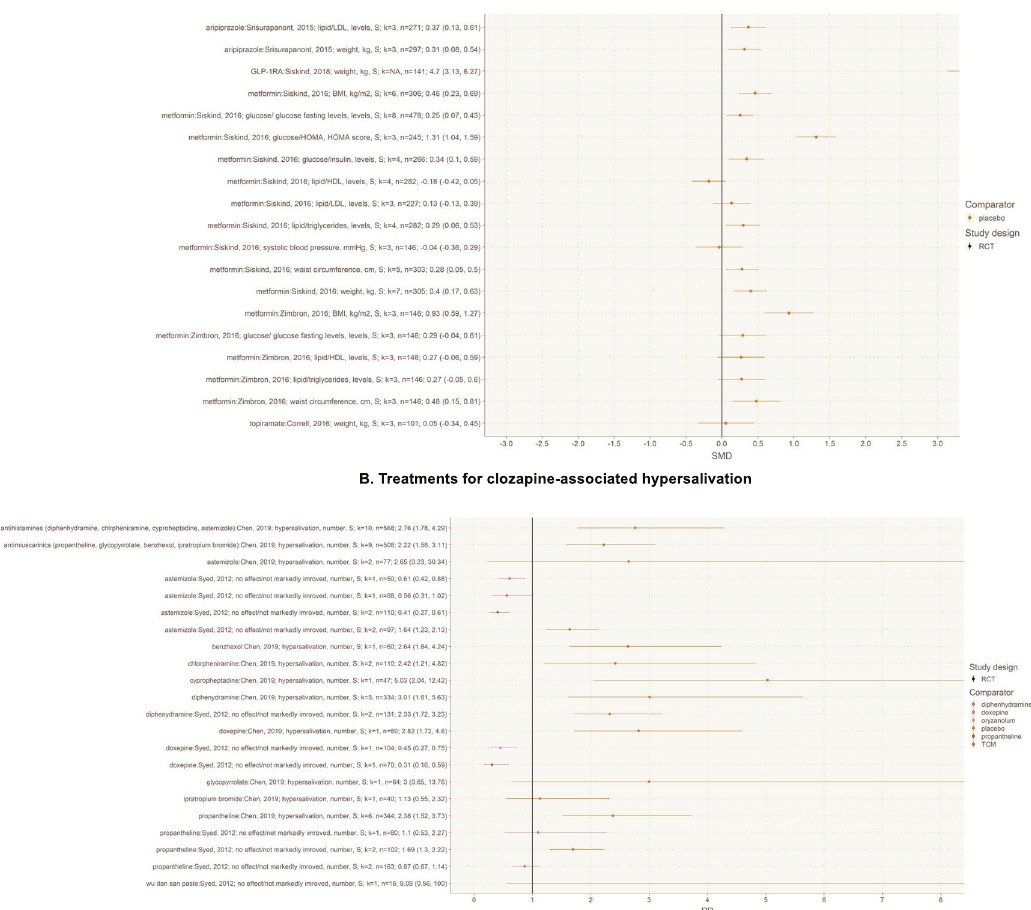
Fig. 4 Add-on strategies for adverse-event management. A Treatment options for clozapine-associated metabolic dysfunctions. BMI body- mass index, cm centimeter, GLP-1RA GLP-1 receptor agonist, HDL high-density lipoprotein, HOMA homeostatic model assessment for insulin resistance, k number of studies, kg kilogram, L long-term, LDL low-density lipoprotein, M medium-term, n number of participants, RCT randomized-controlled trial, S short-term. For continuous outcomes, SMD > 0 means a bene fi cial outcome for clozapine (e.g. more response or less adverse events. B Treatment options for clozapine-associated hypersalivation. k number of studies, L long-term, M medium-term, n number of participants, RCT randomized-controlled trial, S short-term. For dichotomous outcomes, RR > 1 means a bene fi cial outcome for clozapine (e.g. more response or less adverse